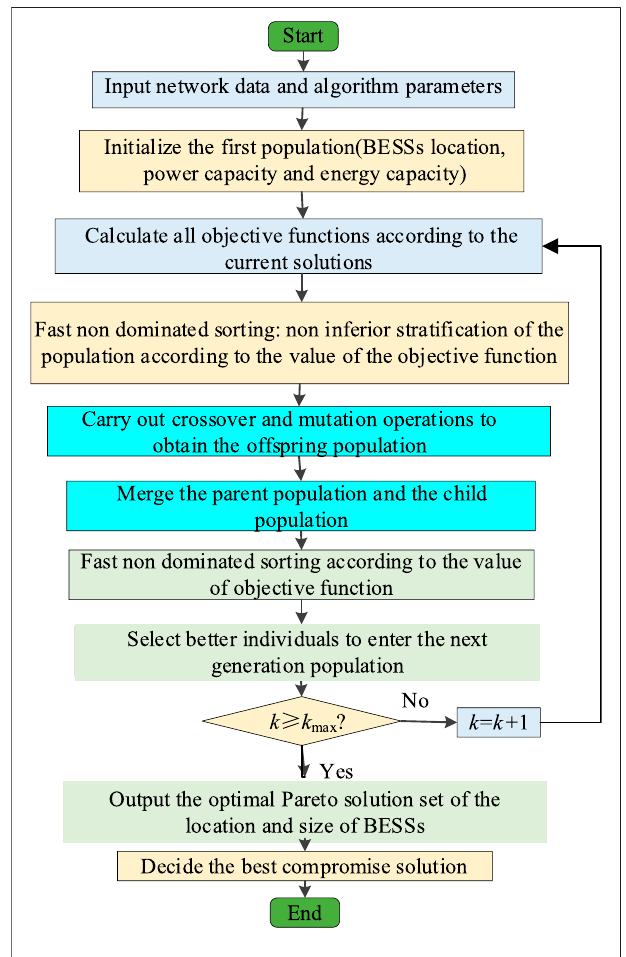
FIGURE 1 | Flowchart of NSGA-II for the optimal location and size of